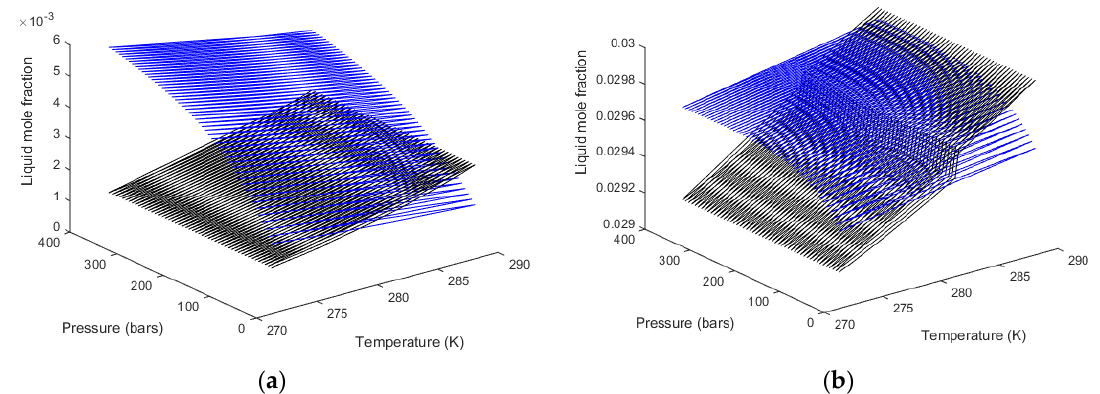
Figure 7. ( a ) Solubility of CH 4 in liquid water (blue) and lower limit of hydrate stability (black). ( b ) Solubility of CO 2 in water (blue) and lower limit of hydrate stability. Hydrate can grow from solution for concentration below the blue and black contours. Concentrations of hydrate formers in surrounding water less than the black contours lead to hydrate dissociation. Possible concentration of hydrate formers in water above the blue contours lead to degassing from water solution. Examples of the free energies of hydrates from water and CH 4 , and water and CO 2 are given in Figure 10b as function of temperature and pressure. Free energies for hydrates formed homogeneously from solution are different but the relative picture between CH 4 hydrate and CO 2 hydrates are similar.